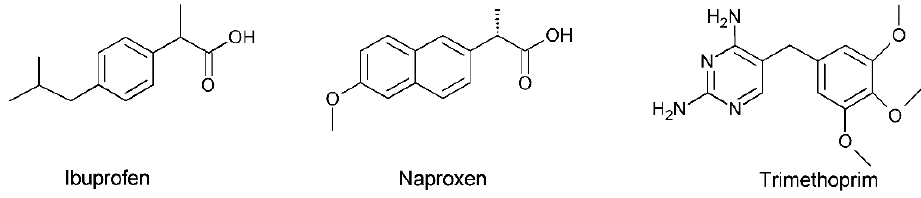
Figure 15. Some drugs encapsulated in polyphosphazene-based microspheres.